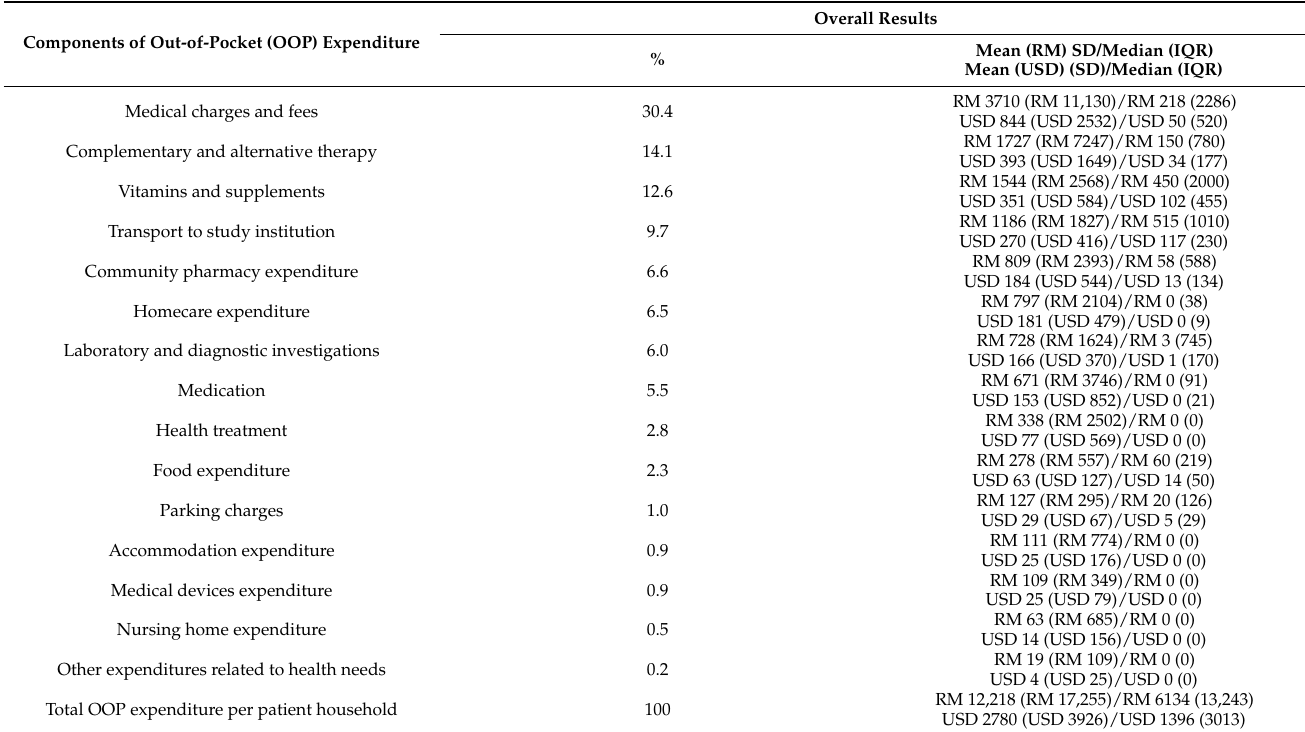
Table 2. Components of total out-of-pocket expenditure incurred by households with gynaecological cancer ( n = 120).